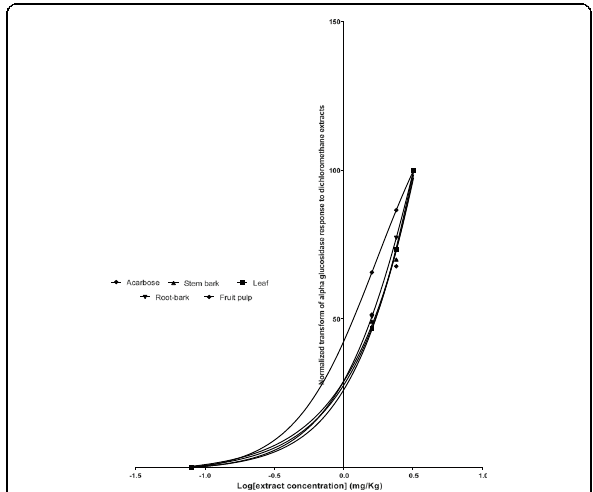
Fig. 13 Percentage inhibition of α -glucosidase by dichloromethane extracts of Annona muricata fruit-pulp, leaf, stem-bark, root-bark and acarbose (reference standard)